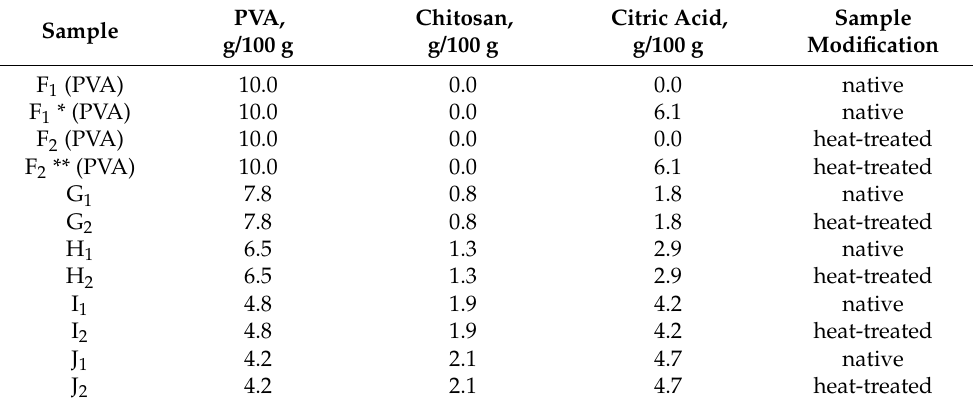
Table 1. Composition of the initial polymer